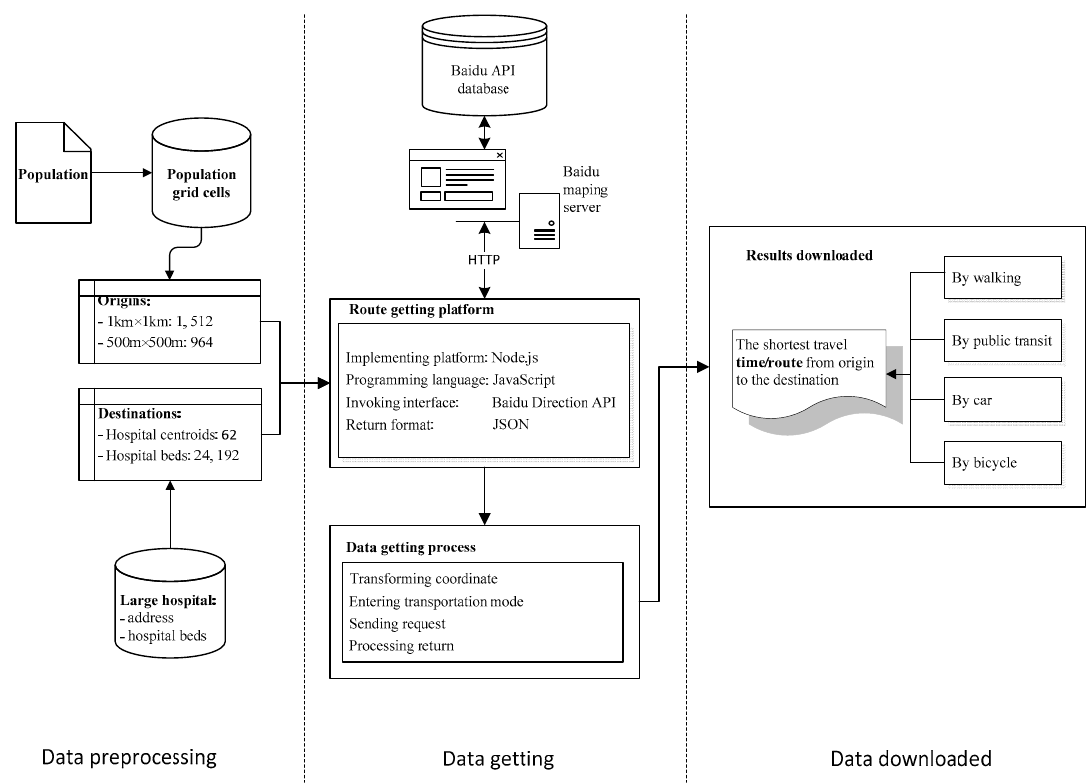
Figure 4. The calculating procedures of the OD travel cost by Baidu map application program interfaces (APIs).